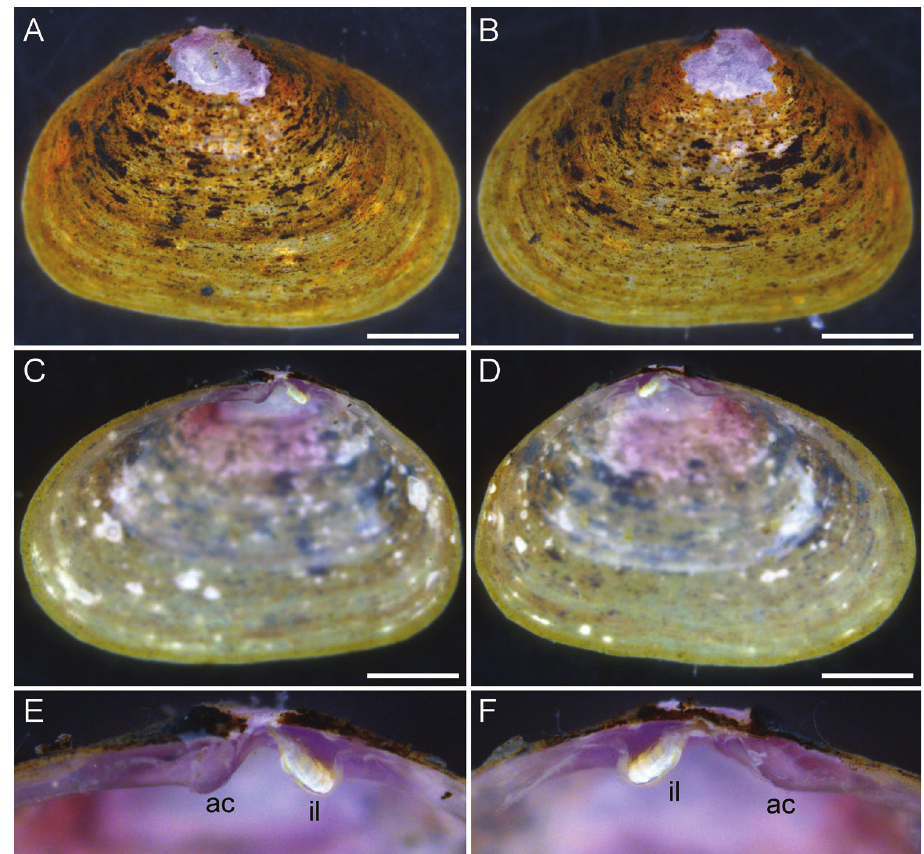
valve E, F Hinge structure of right and left valves. Abbreviations: ac, anterior cardinal tooth; il, internal ligament. Scale bars 0.5 mm. Photo credits: R. Goto: A–F